Question: Provide a one-line summary of what is displayed.
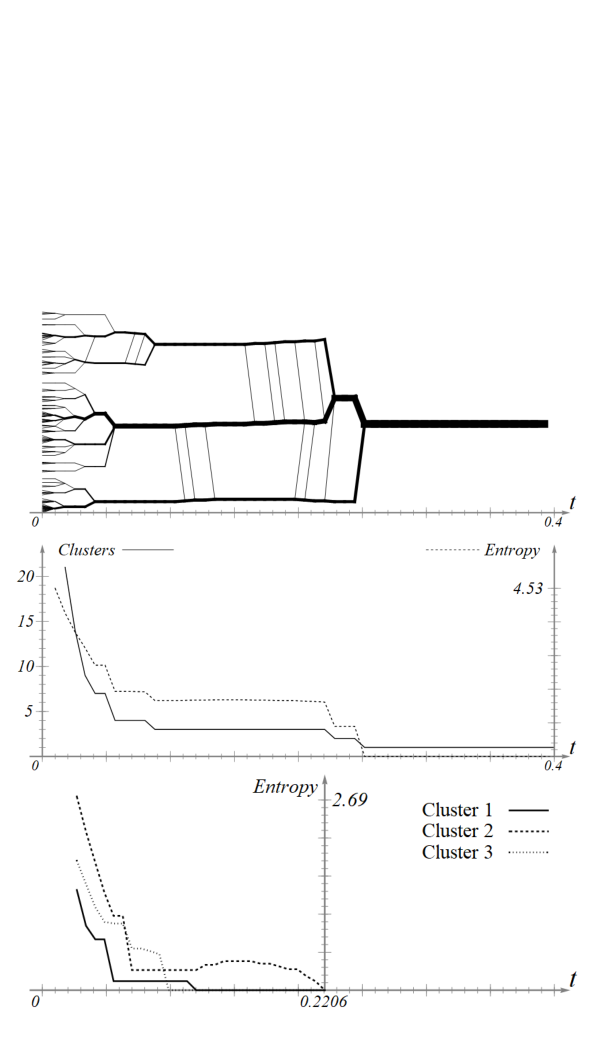
Answer: Top: Chronodendrogram for the noisy dataset. Middle: The entropy and cluster number, showing stability at 3 clusters. Bottom: The local entropy scores for each of the three clusters observed at time t = 0.2206.